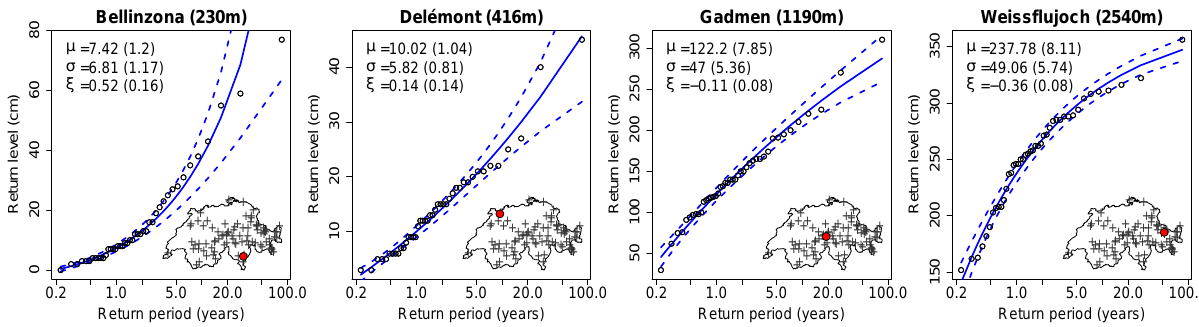
Fig. 3. Snow depth return level plots for four different stations. The blue curve is the GEV-based curve with standard errors (dashed line). Points are empirical estimates. Locations of the stations are indicated by the red circle in the lower-right Swiss map. Maximum likelihood estimates of the GEV parameters are indicated the upper-left corner (with standard errors).